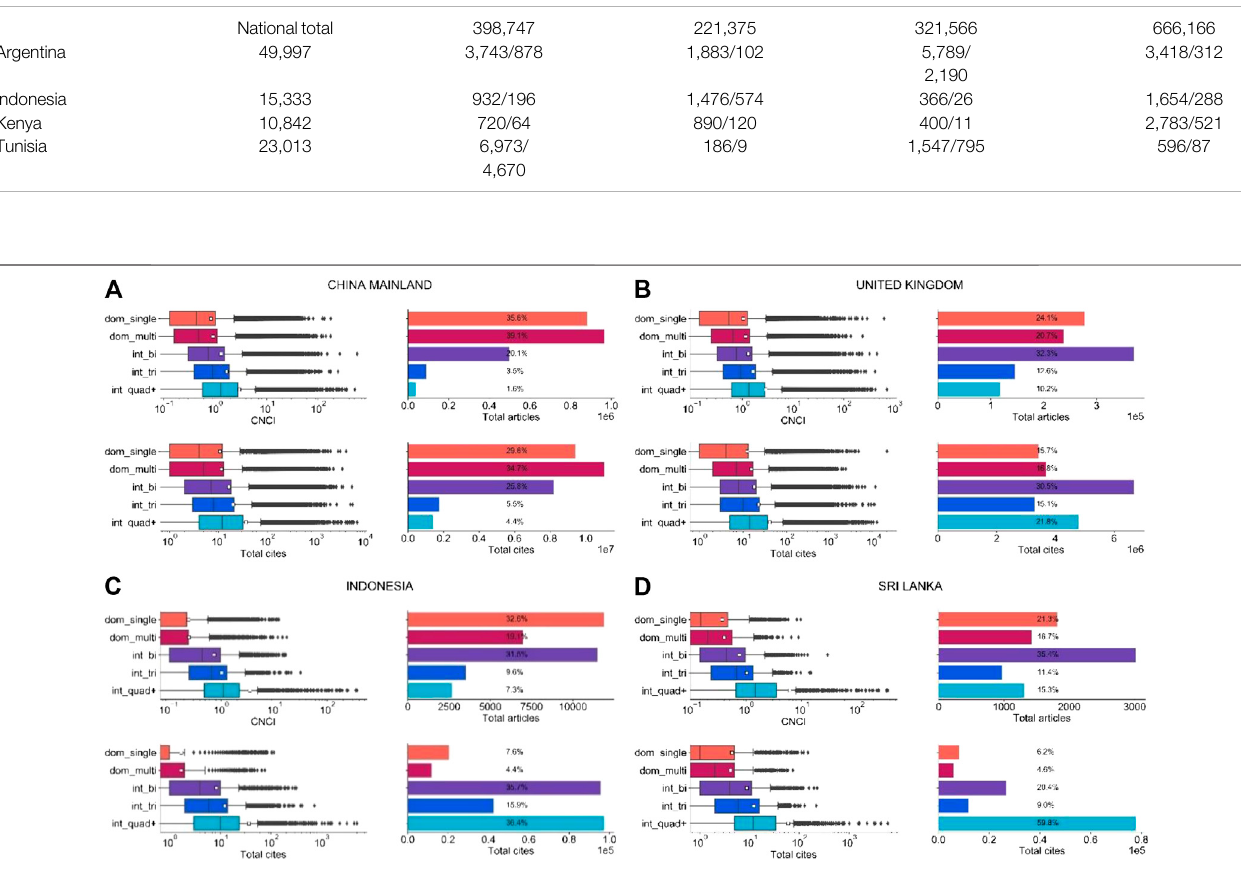
Figure 6 | (A) – (D) Deconstructed article and citation distribution output for China, the United Kingdom, Sri Lanka and Indonesia (2009 – 2018). Articles are divided into fi vetypes:domesticsingle(dom_single)andmulti(dom_multi),andinternationalbilateral(int_bi),trilateral(int_tri)andquadrilateral-plus(int_quad+).Whitesquareson boxplots represent the mean. Data reproduced from Potter et al. (2020, Figure 6 ). (A) China (B) United Kingdom. (C) Indonesia (D) Sri